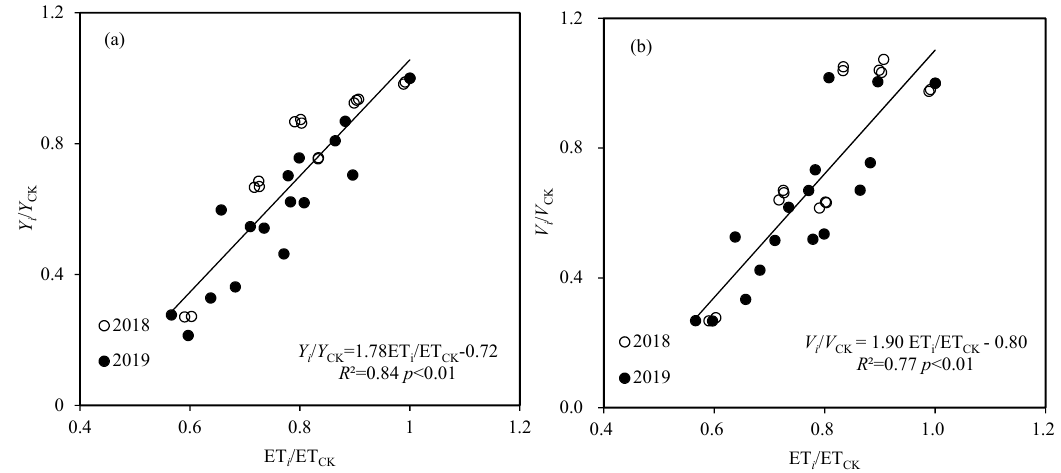
Figure 3. Linear relationships between relative yield ( Y i / Y CK ) and relative seasonal evapotranspiration (ET i / ET CK ) ( a ), as well as relative seed vigor evaluated by a combinational evaluation method ( V i / V CK ) and ET i / ET CK ( b ).